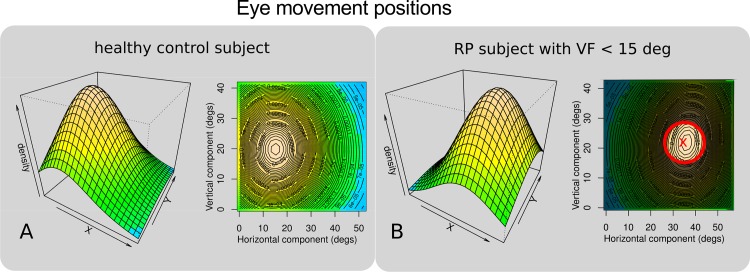
Perspective and contour plots of two-dimensional kernel density estimations of horizontal and vertical eye movement positions.Eye positions (horizontal and vertical on the abscissa and ordinate, respectively) and visual field horizontal diameters are given in degrees. Density represents the time the eye spent at any particular position (x,y) during the whole walk and are given in percentages. In 5A typical eye movement positions of a normal observer in the light condition are shown. In 5B are shown the typical eye movement positions of an RP patient (visual field depicted by the red circle surrounded by the shaded gray area) in the light condition.